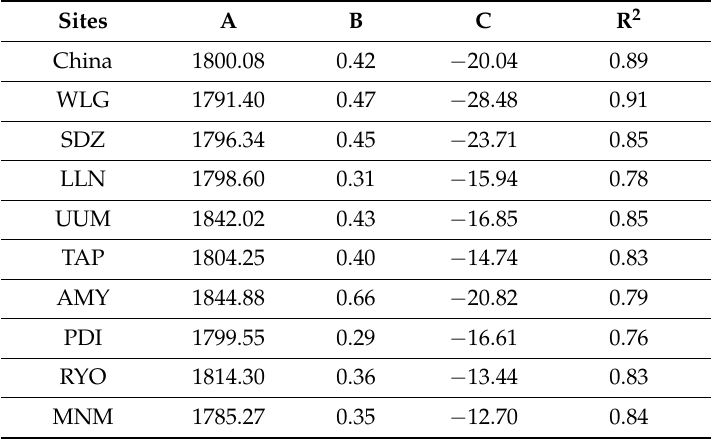
Figure 6. ( a ) Sinusoidal fitting results of the monthly averaged CH 4 concentration across China from September 2002 to September 2016; ( b ) the correlation between atmospheric CH 4 concentration, and emissions from EDGAR. Table 3. Comparison of the fitting parameters among the average CH 4 , and nine surface sites from 2002 to 2016 (ppb).